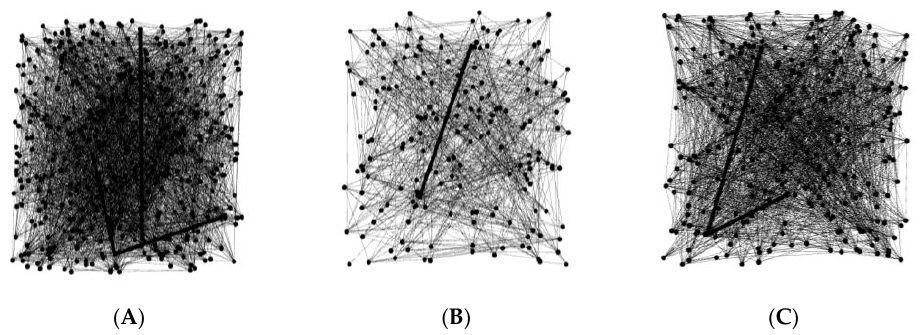
Figure 5. Different network topological properties from a part of data sets, ( A ) depicts the average clustering coefficient, ( B ) depicts average degree, respectively. It is worth noting that both the aver- age clustering coefficient and the average degree of the CT images with artifacts are larger than those of the CT images without artifacts, respectively.